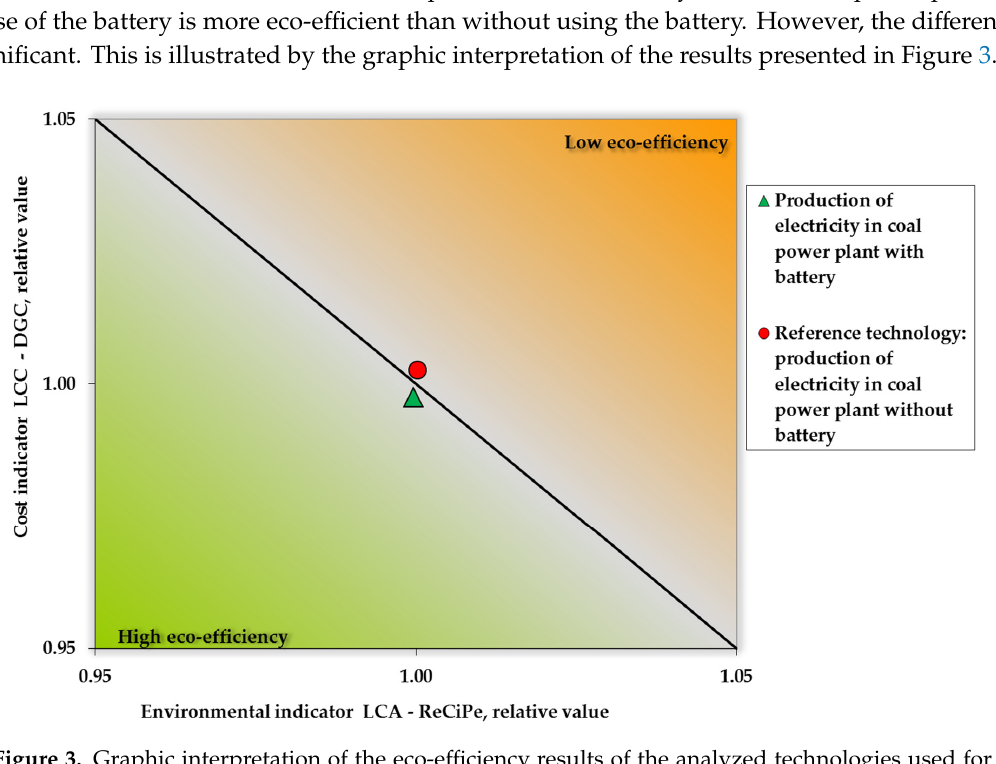
Figure 3. Graphic interpretation of the eco-efficiency results of the analyzed technologies used for electricity production in a coal-fired power plant.